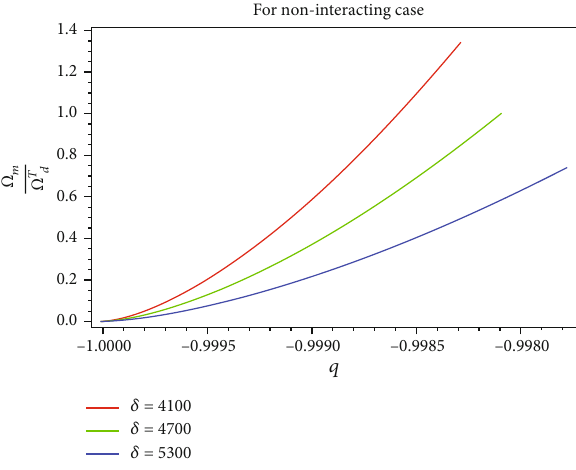
Figure 12: Plot of EoS parameter ω T